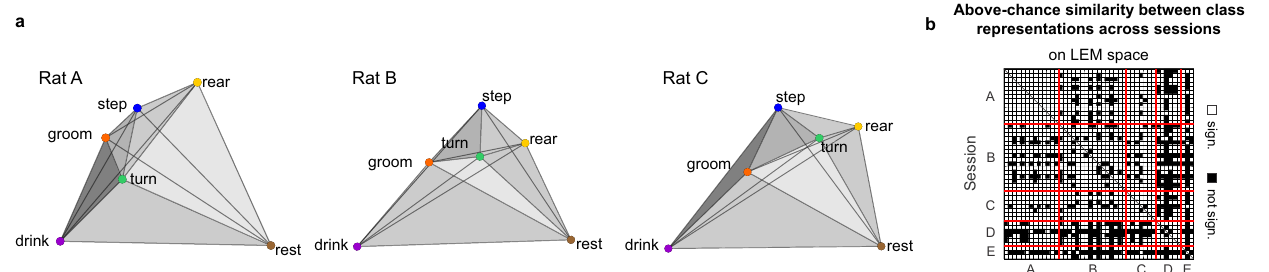
Fig. 3 | Cross-session polytope comparison reveals similarities in the average encoding of behavioral classes across animals. a 3D polytopes in the LEM space identi fi ed by the average population vectors of the six behavioral classes for one example session of Rats A, B, and C, respectively. The distances between the polytope vertexes are proportional to the distances computed between the aver- age populationvectorsinthe3DLEMspace.The grayshadingisadded tovisualize the 3D structure. b Signi fi cant similarities among the polytope structures of dif- ferentsessions.Similaritywastestedforeachpairofsessionsbycomparing,across